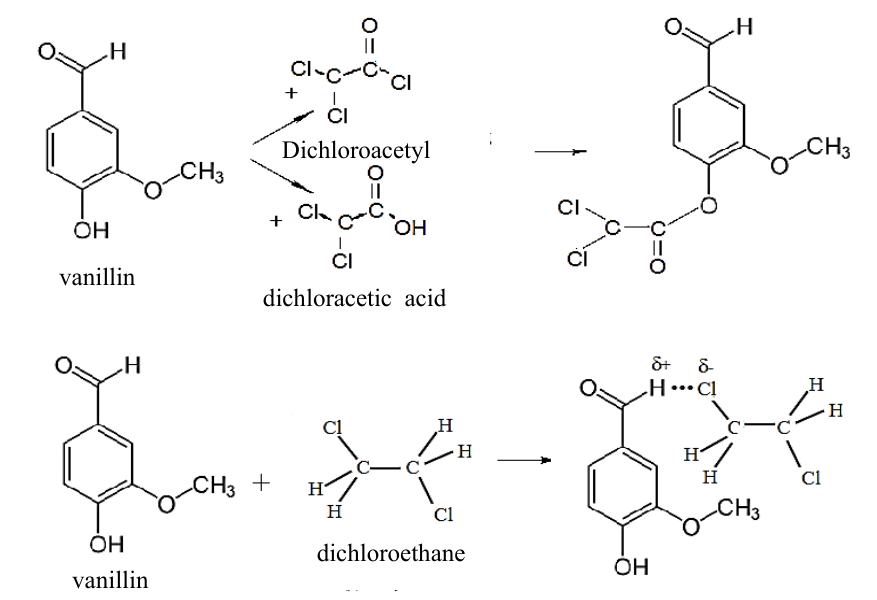
Fig. 7. Chemical interaction of vanillin with the priority contaminants contained in water.